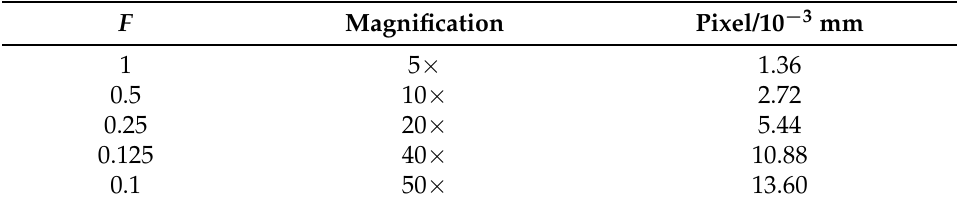
Figure 3. 200 × 200 pixel images used for training, their derived S values and alloy. Table 1. Magnification factor F and appropriate pixel per micrometer